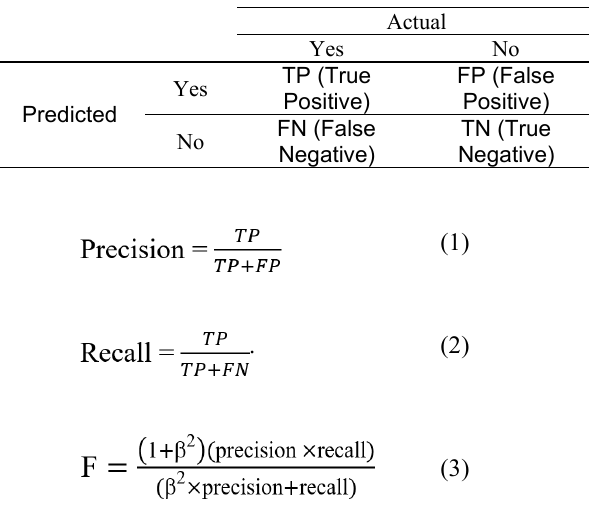
Table 2. Confusion